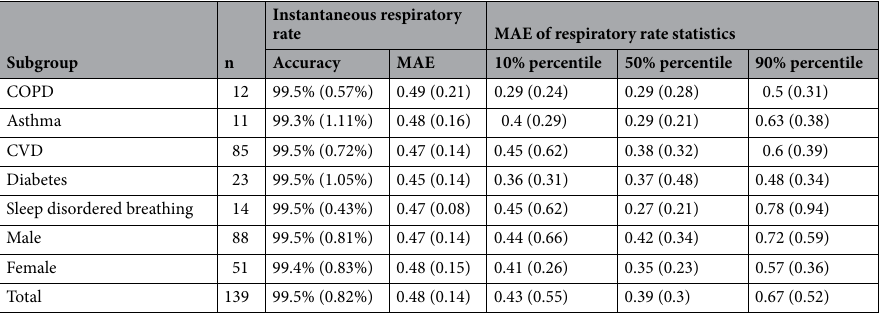
Table 4. Subgroup analysis of respiratory rate performance of Study 2. Numbers in parenthesis correspond to standard deviation. Participants can be included in more than one subgroup, as subgroups are defined by the presence of a diagnosed condition, and not by the absence of all other conditions, e.g. a participant with COPD and diabetes is included in the two subgroups.